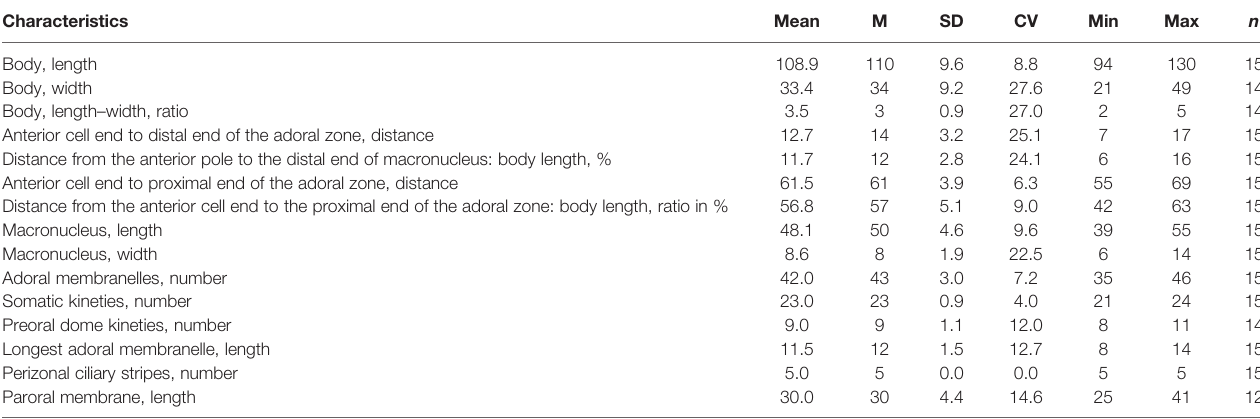
TABLE 1 | Morphometric characteristics of Metopus paraes sp. n. based on protargol-stained specimens. Measurements in m m.